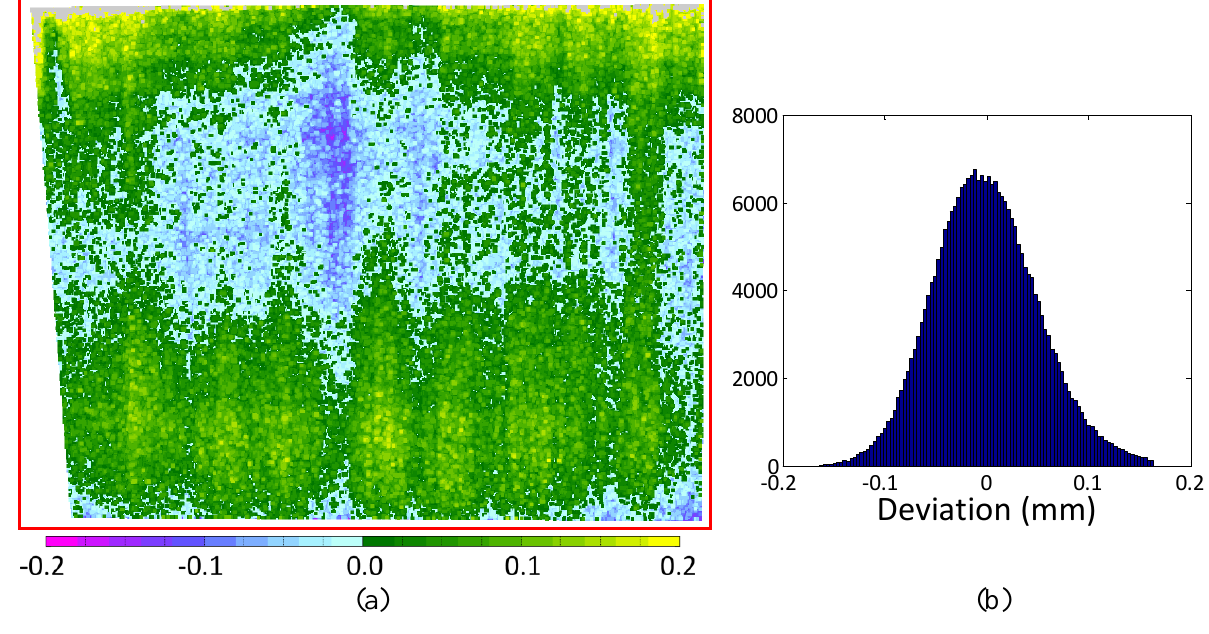
is the 1 on the 50 mm × 50 mm 2